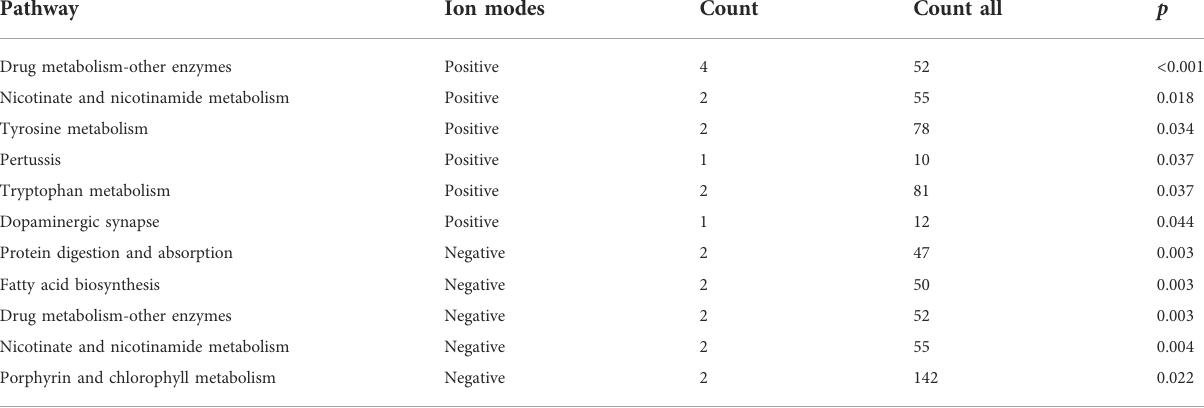
TABLE 3 Enrichment table of metabolic pathways for differential metabolites. Pathway Drug metabolism-other